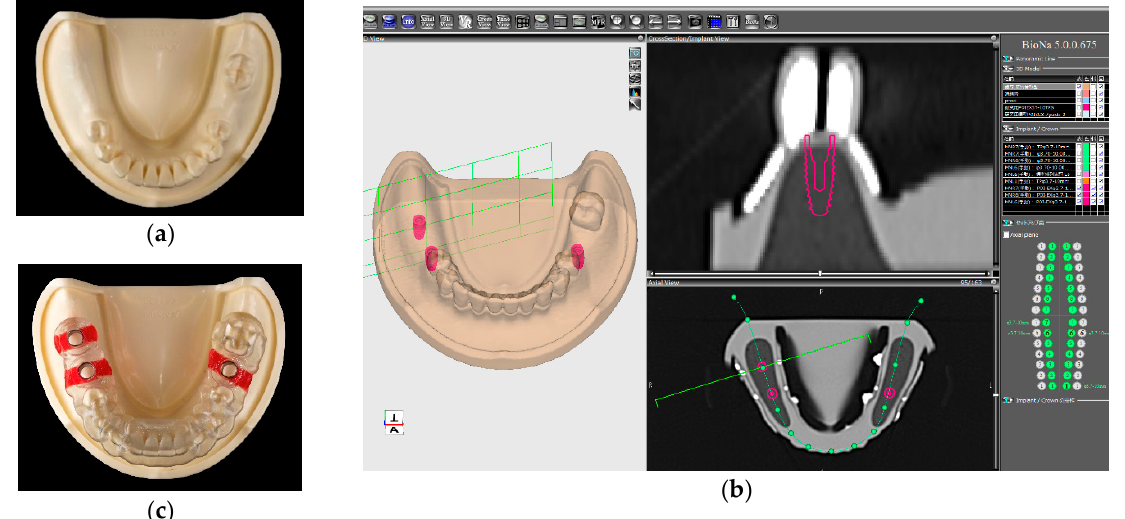
Figure 1. ( a ) The mandibular model used for the study. ( b ) Three implants were virtually planned